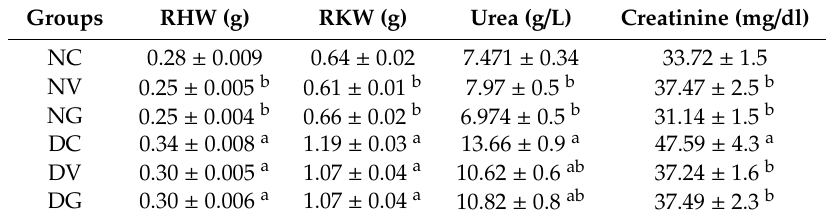
Table 2. Relative organ weights and kidney function parameters following treatment.